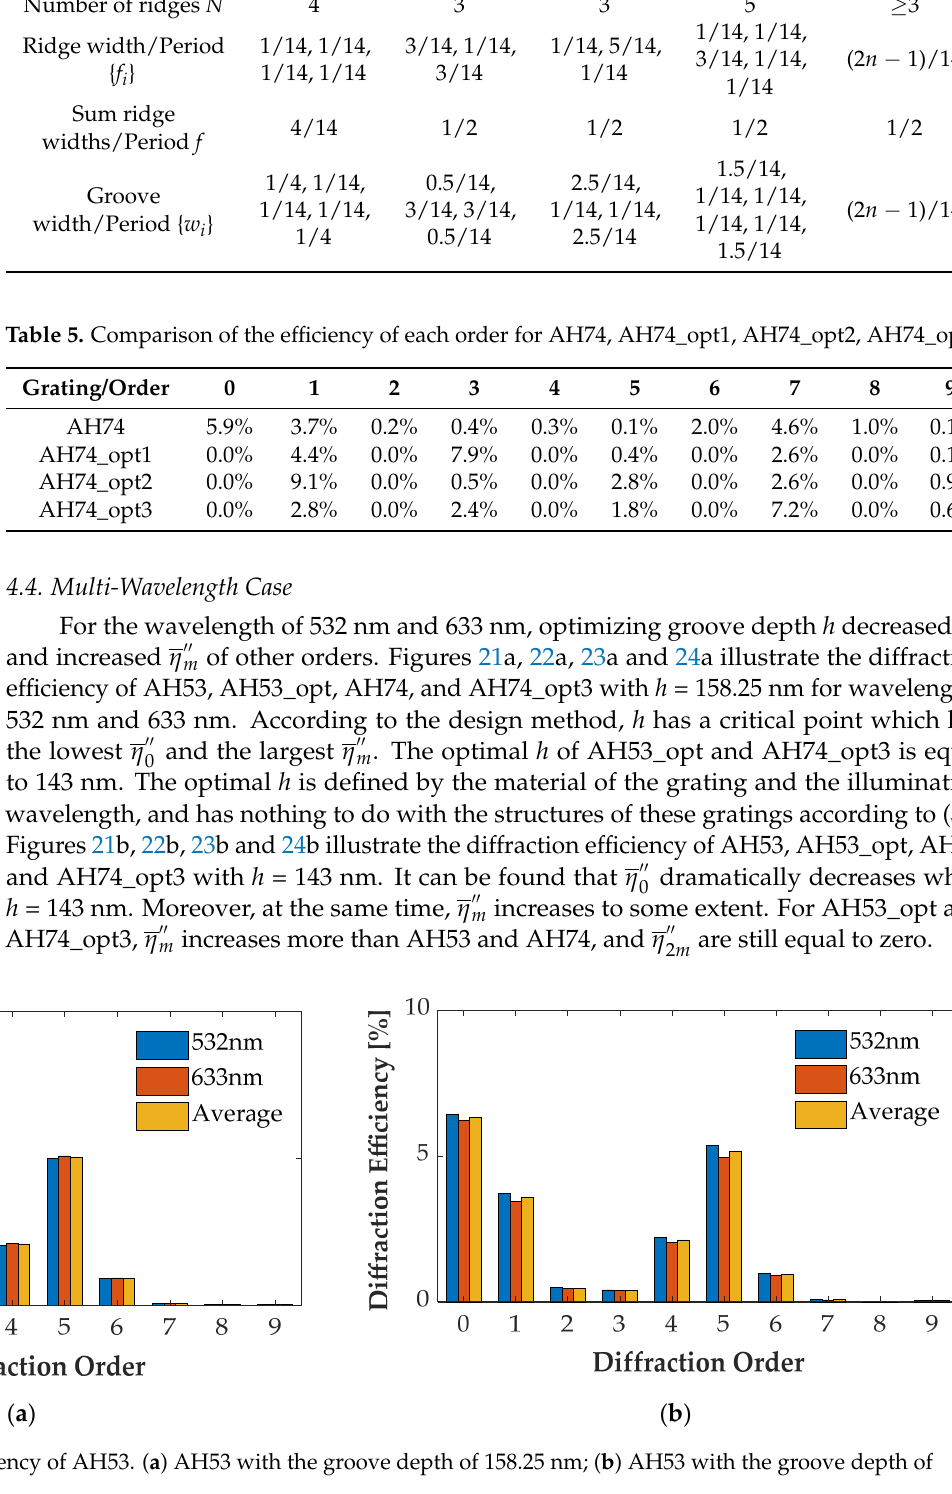
Table 5. Comparison of the efficiency of each order for AH74, AH74_opt1, AH74_opt2,